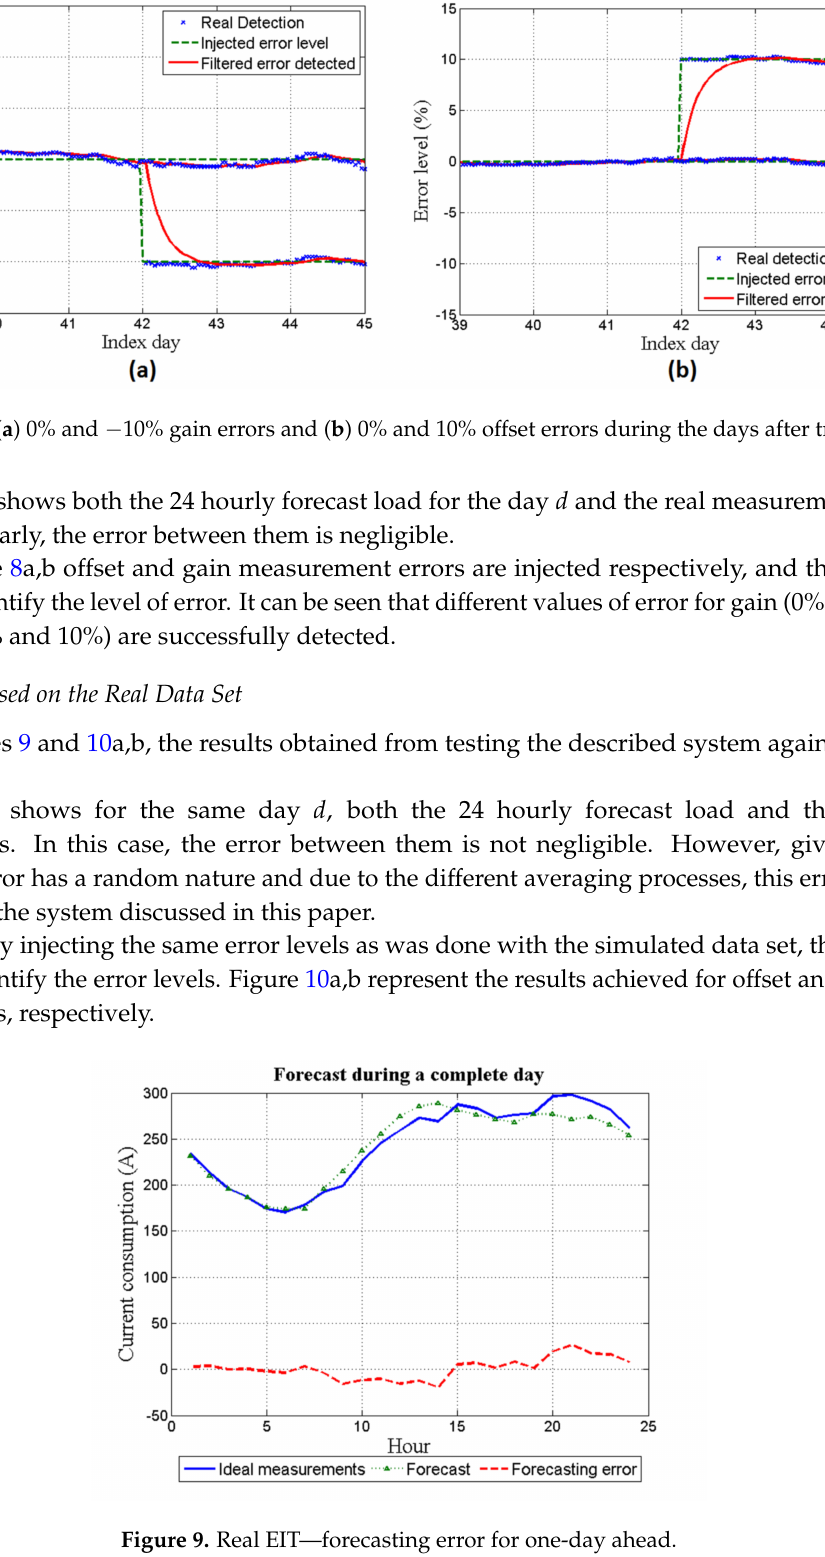
Figure 9. Real EIT—forecasting error for one-day